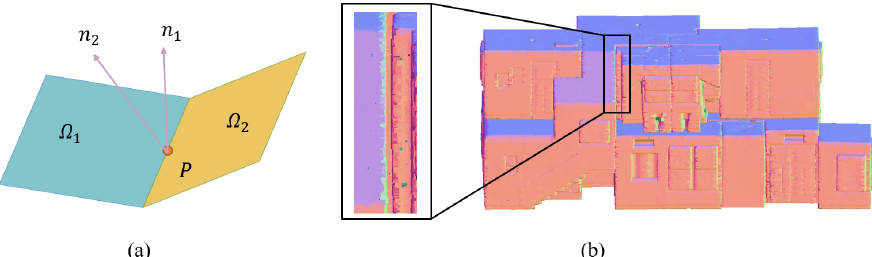
Figure 3. ( a ) Normal Ambiguity. The normal of boundary p is not explicit, instead depended on which mesh the neighbors are located during calculation. ( b ) an example of normal ambiguity. Normals are differently colored according to their orientations. The boundary between the zoomed purple and green surfaces is not